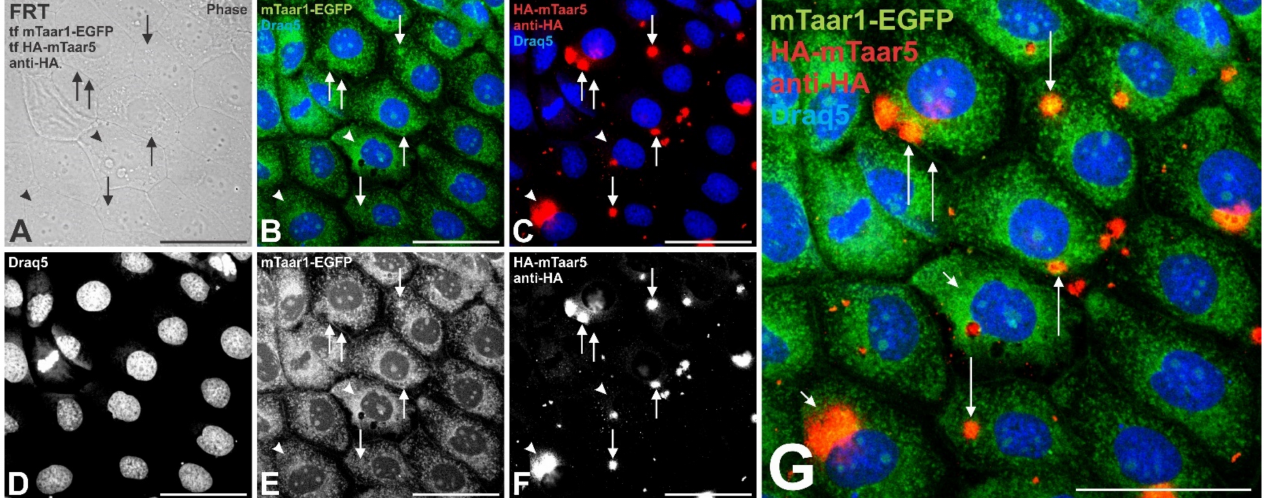
Figure 9. Co-expressing mTaar5 in FRT cells enhances trafficking of mTaar1-EGFP to lipid raft-like microdomains and the ciliary plasma membrane. ( A – G ) FRT cells co-expressing mTaar1-EGFP (green) and HA-mTaar5 , labeled with HA-specific antibodies (red in C , white in F ) show co-localization at lipid raft-like microdomains and at cilia (yellow in G , arrows) besides a predominant ER-localization of mTaar1-EGFP (green in B , G , and white in E , arrowheads). Merged fluorescence ( B , C , G ) and corresponding single ( E , F ) or phase contrast micrographs ( A ) are provided as indicated, and Draq5™ as nuclear counter-stain in ( B – D ). Scale bar represents 50 µ